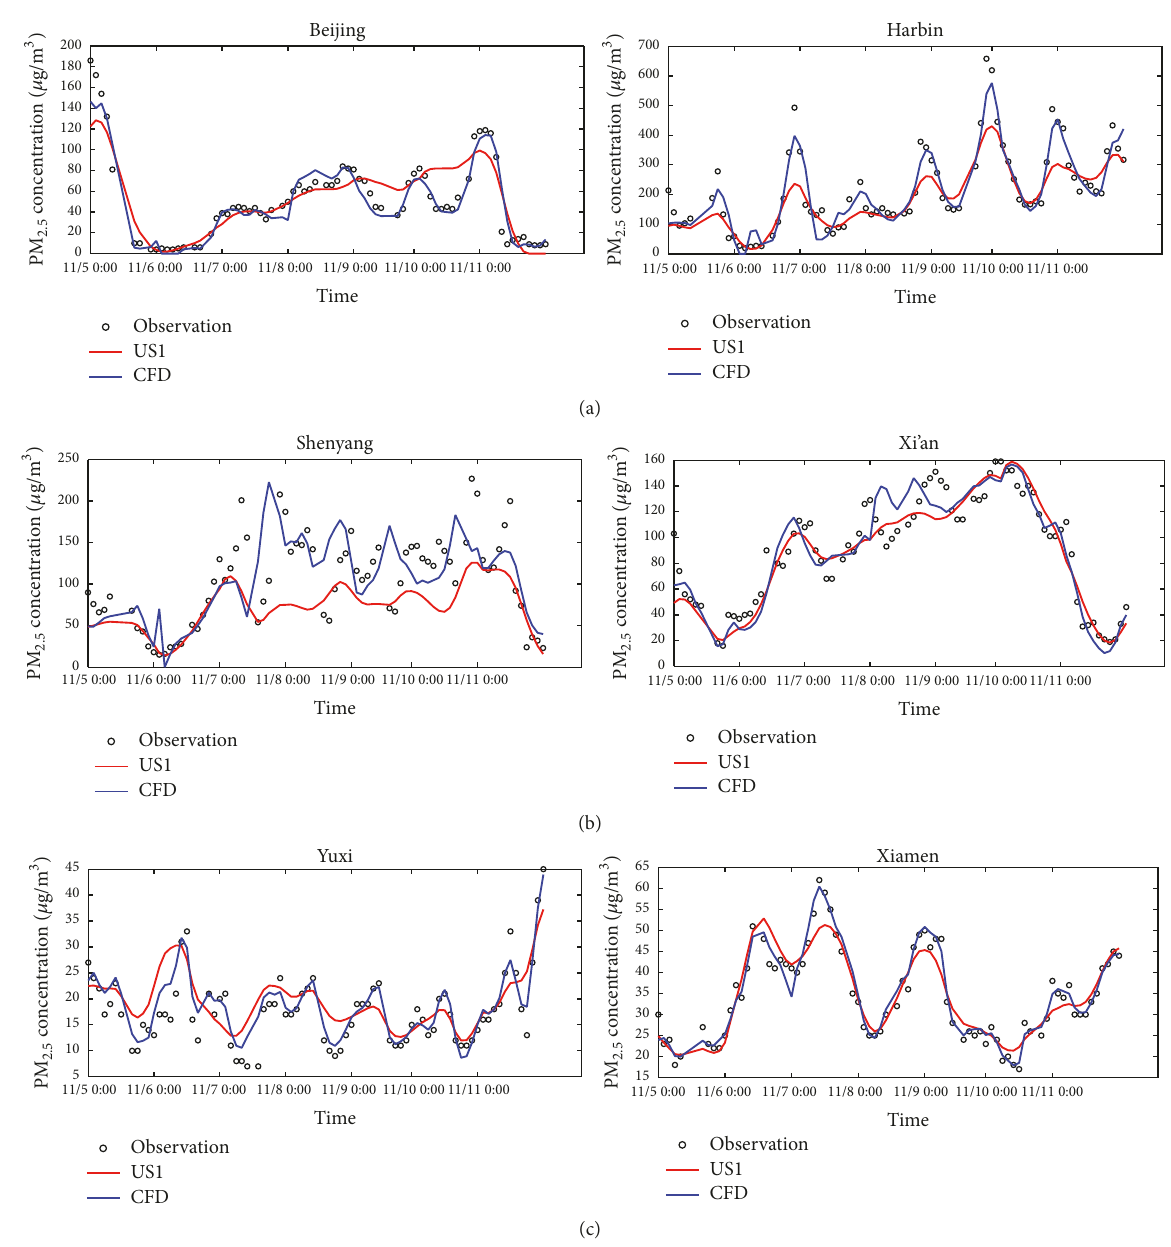
Figure 7: Comparisons of the time series of simulated PM 2.5 concentrations in 6 cities from Nov. 5 to Nov.